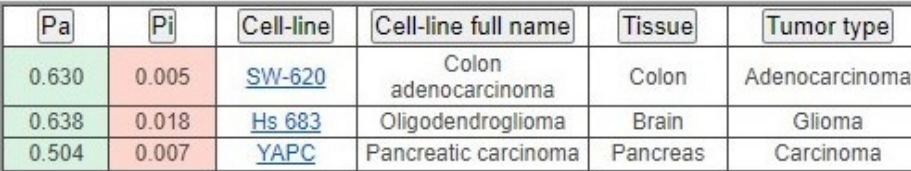
Figure 16. Cancer-cell-line prediction for L2 .